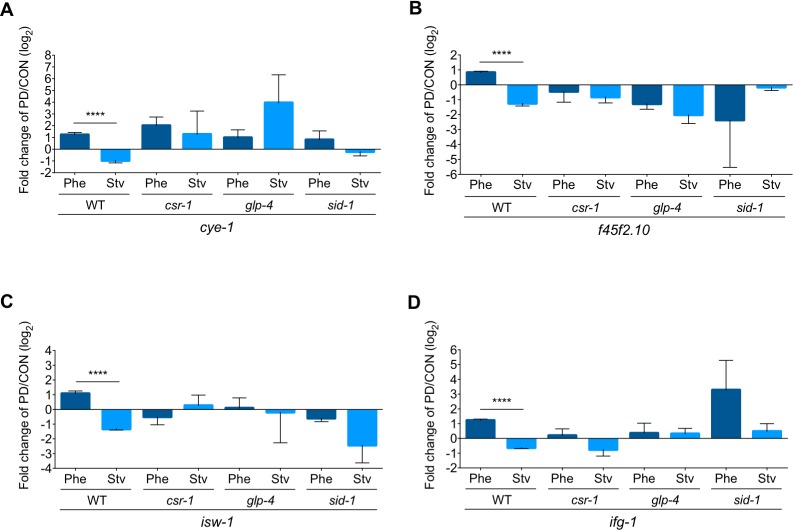
SID-1 and CSR-1 are required for seesaw gene expression changes in the germ line.(A-D) qRT-PCR validation of germline-expressed, CSR-1-targeted seesaw gene PD/CON mRNA levels in WT, csr-1 hypomorph, glp-4(bn2) (grown at 25°C), and sid-1(qt9) strains for Phe and Stv conditions. **** p < 0.0001; Student’s t-test comparison of Phe (PDPhe/CONPhe) and Stv (PDStv/CONStv) within a strain. Error bars represent Standard Error of the Mean (S.E.M.). qRT-PCR validations for additional genes are found in S3, S4, S5, and S6 Figs.